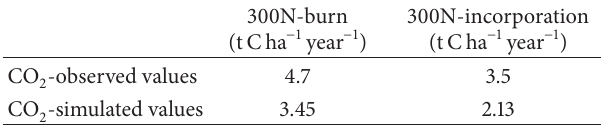
Table 3: The observed and simulated annual CO maize